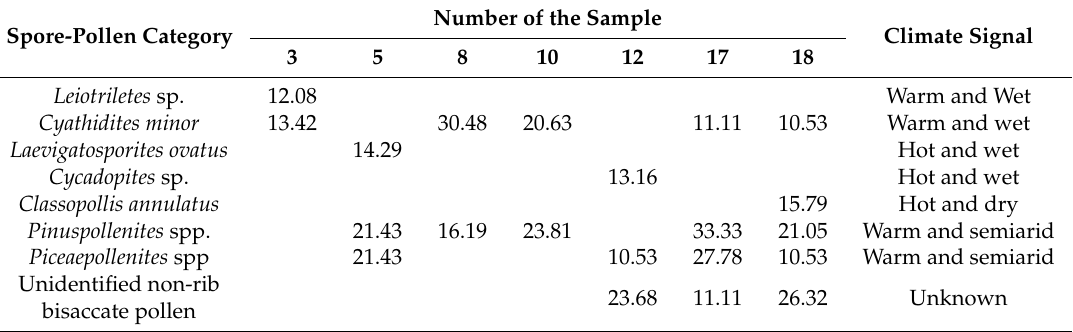
Table 5. Main spore–pollen constituents (>10%) and climate signal (climate signal cited from [24,106,107]).